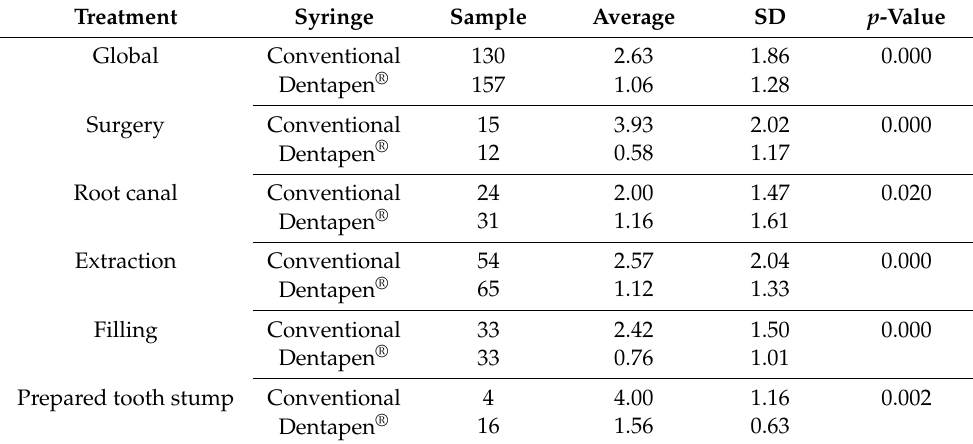
Table 2. VAS (visual analogue scale) comparison and statistical significance, based on type of treatment and the type of syringe